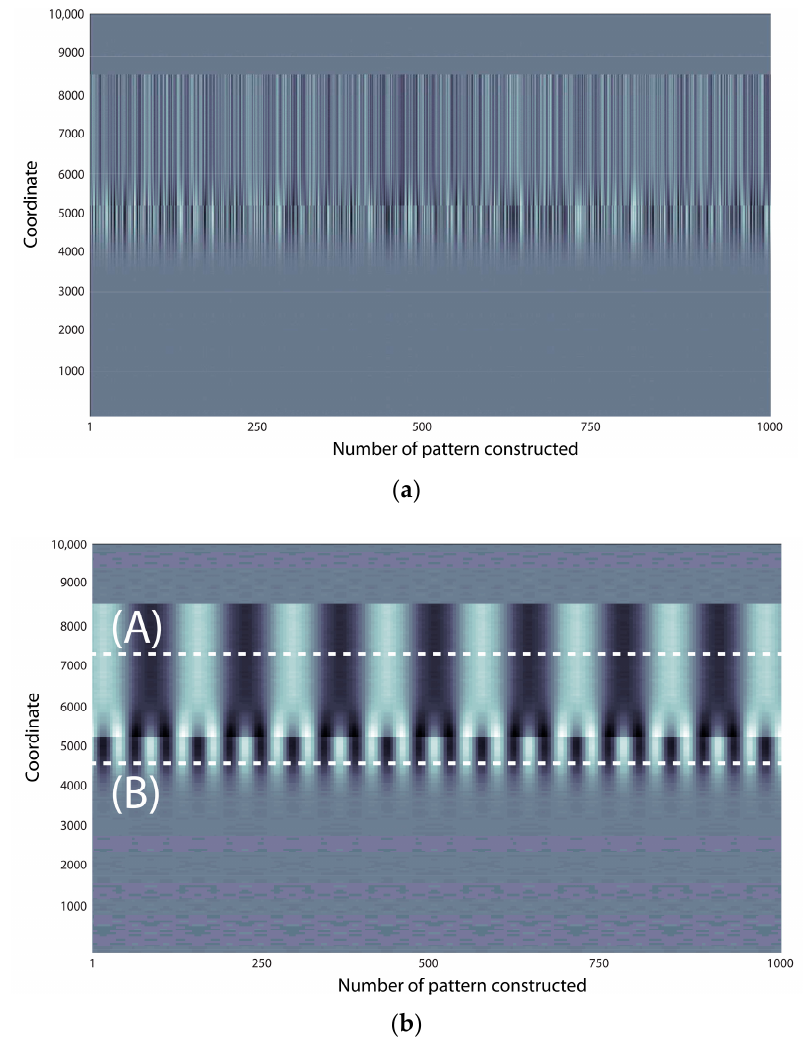
Figure 8. A set of random patterns constructed from the first principal components: ( a ) unsorted patterns; ( b ) sorted patterns. The dashed lines indicate the positions of the two reference points (denoted as A and B).